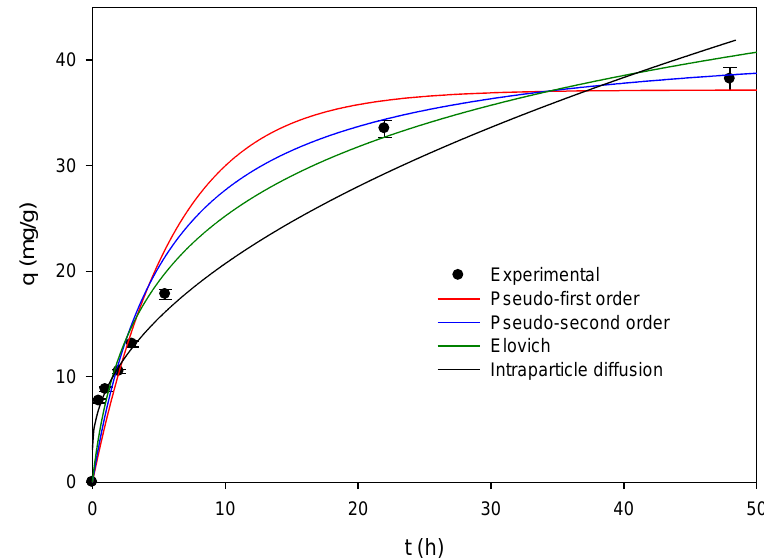
Figure 5. Variation in the adsorption capacity of BPA by activated carbon depending on the contact time and adjustment results of the four kinetic models.